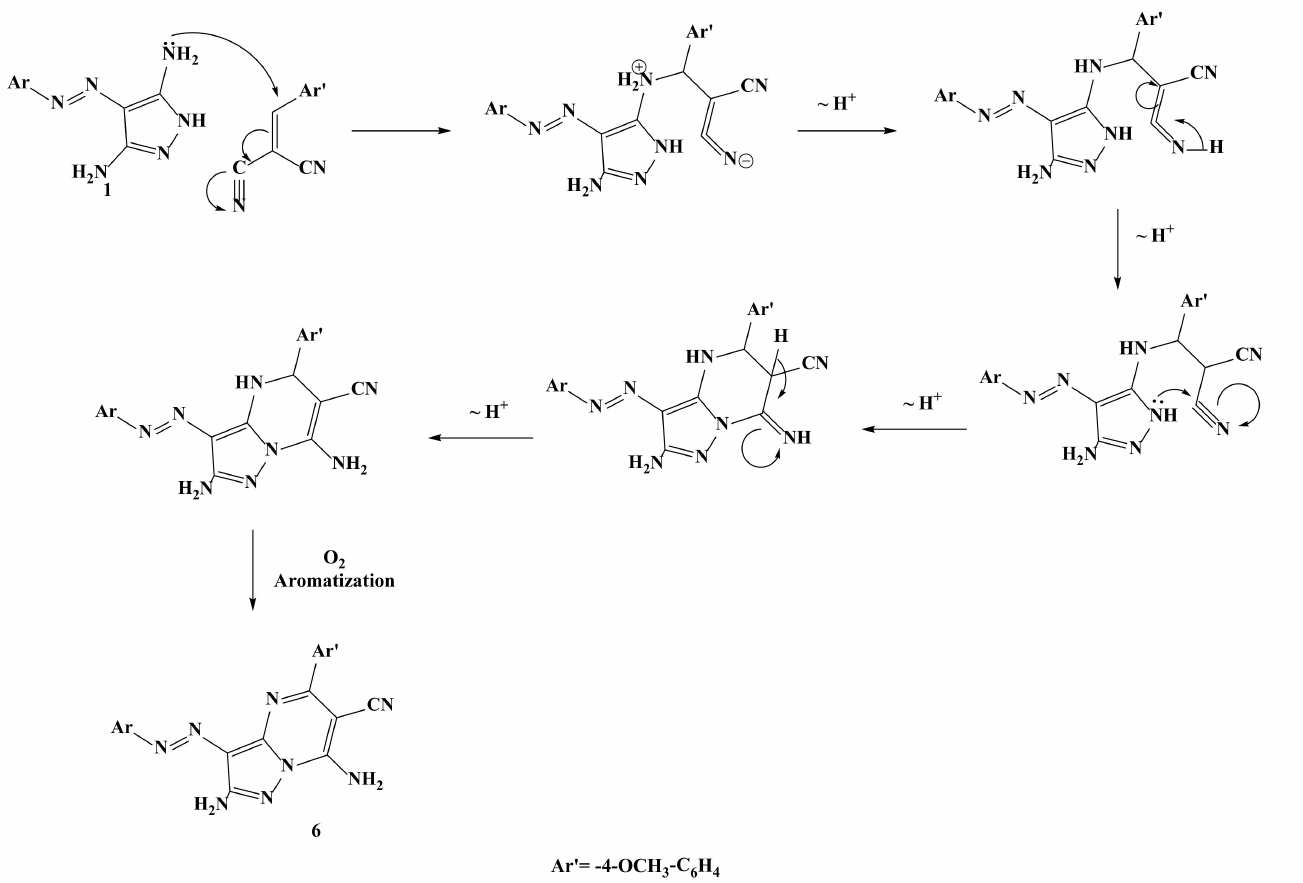
Figure 3. Mechanism of formation of pyrazolopyrimidine derivative 6